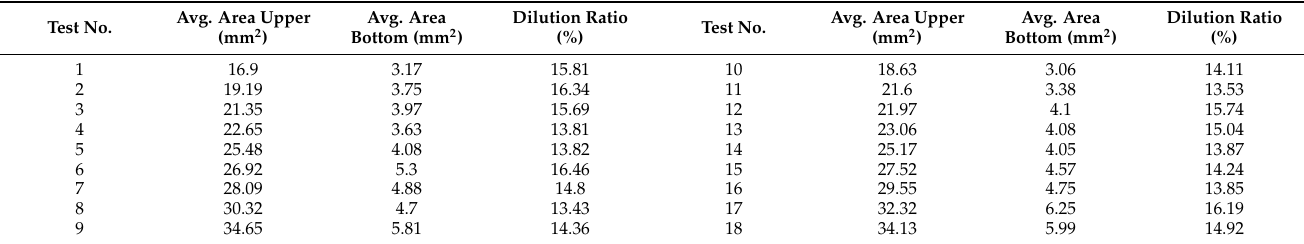
Figure 6. Optical microscope for dilution ratio measurement. Table 7. Results of dilution ratio for flux cored arc welding.